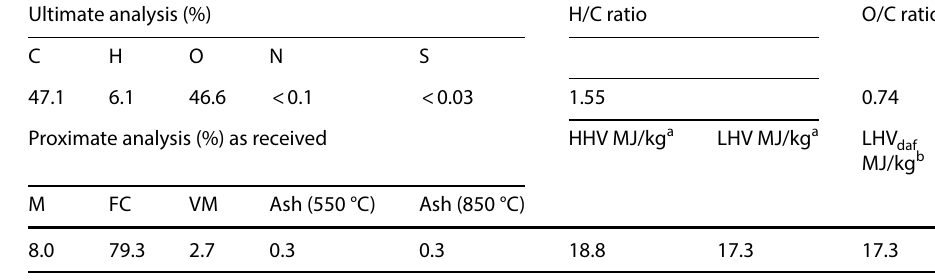
a on raw basis b on dry and ash